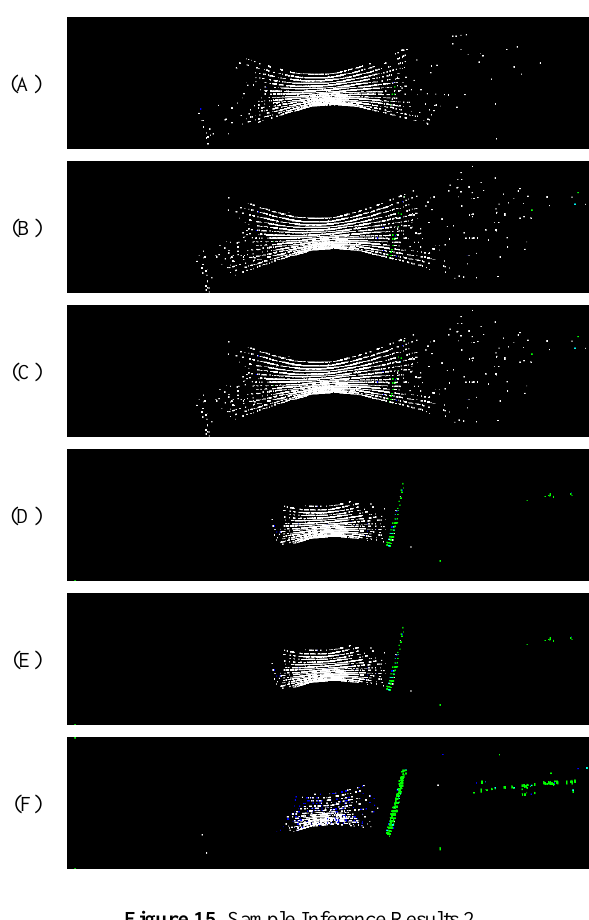
Figure 15. Sample Inference Results